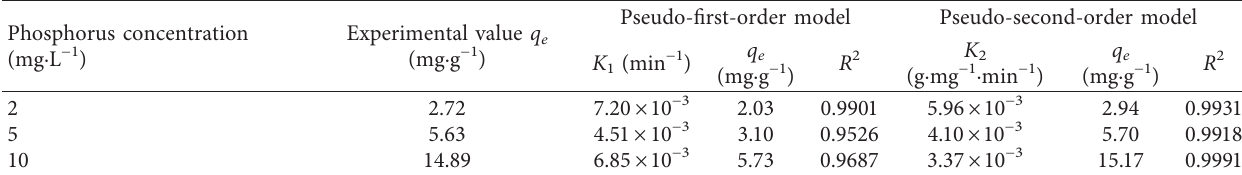
Table 6: Pseudo-first-order and pseudo-second-order kinetics